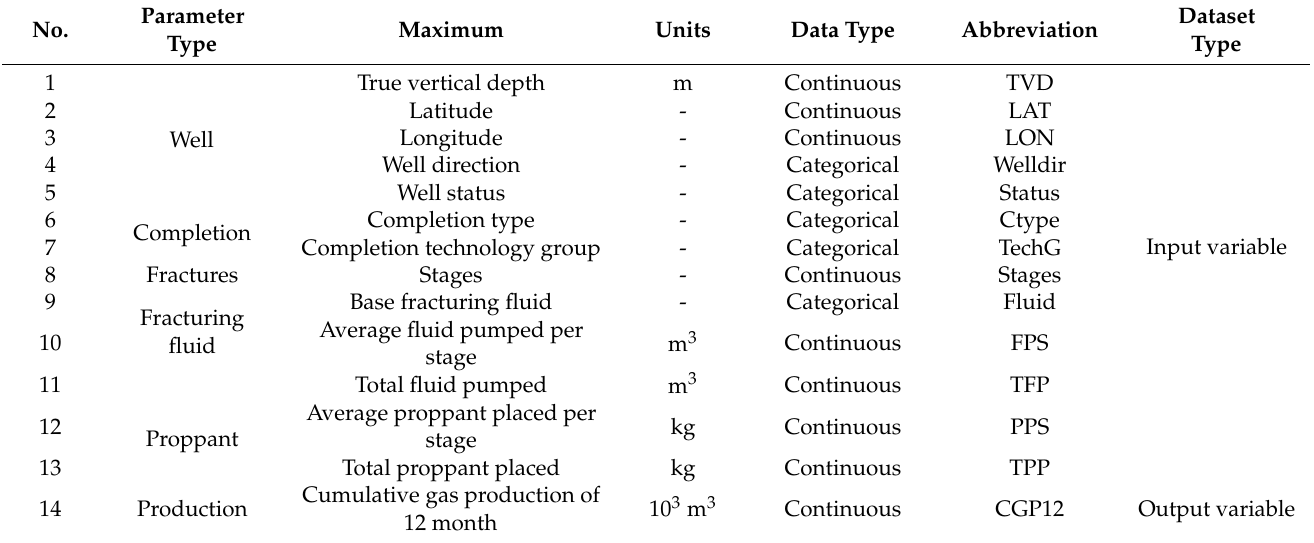
Table 2. List of variables characteristics in the study datasets.